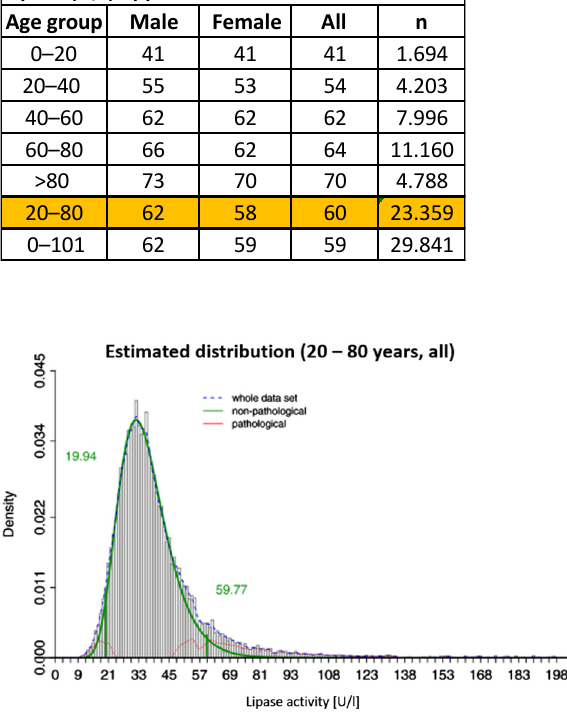
Table  : Upper reference limits calculated for different age groups. Lipase (U/l) upper reference